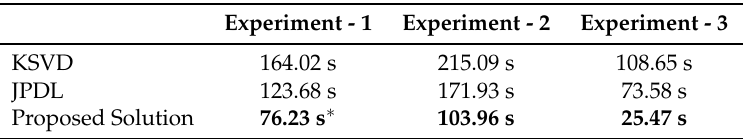
Table 4. Processing Time